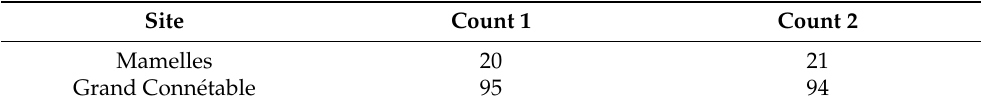
Table 4. Repeatability of goliath groupers ( Epinephelus itajara ) counting with a P900-130 BlueView acoustic camera.